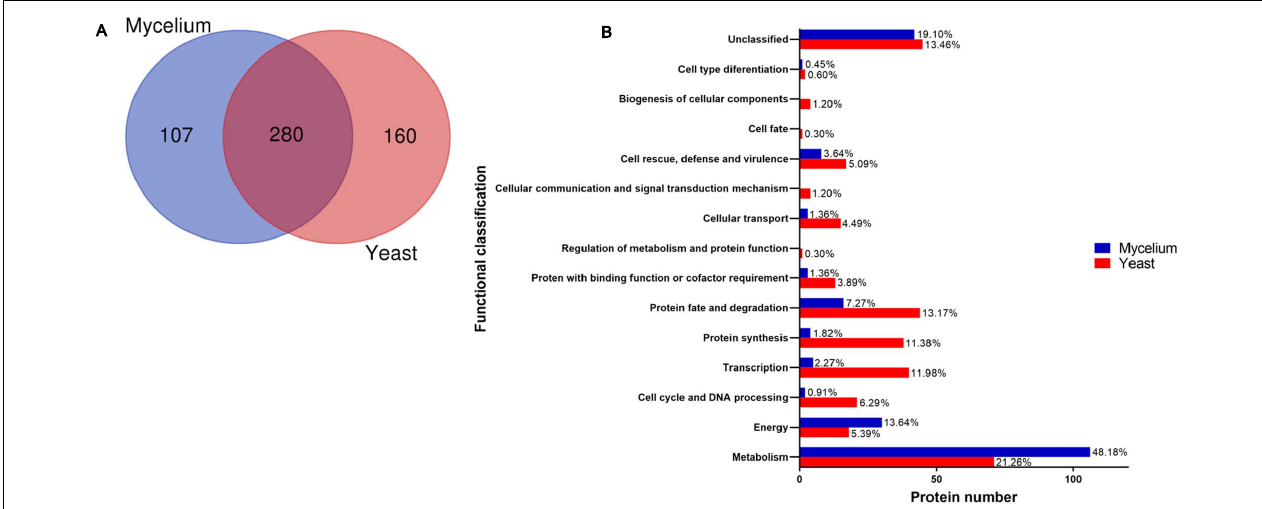
FIGURE 1 | Proteome profile of Histoplasma capsulatum mycelium and yeast forms. (A) Venn diagram presenting the total number of proteins identified in extracts from both H. capsulatum morphologies (http://bioinformatics.psb.ugent.be/webtools/Venn/); (B) Functional classification of H. capsulatum proteins obtained by NanoUPLC-MS E analysis identified with preferential abundance in mycelium and yeast forms. The biological processes of the differentially expressed proteins in the isolates were obtained using the Uniprot (http://www.uniprot.org) and KEGG: Kyoto Encyclopedia of Genes and Genomes (www.genome.jp/kegg).